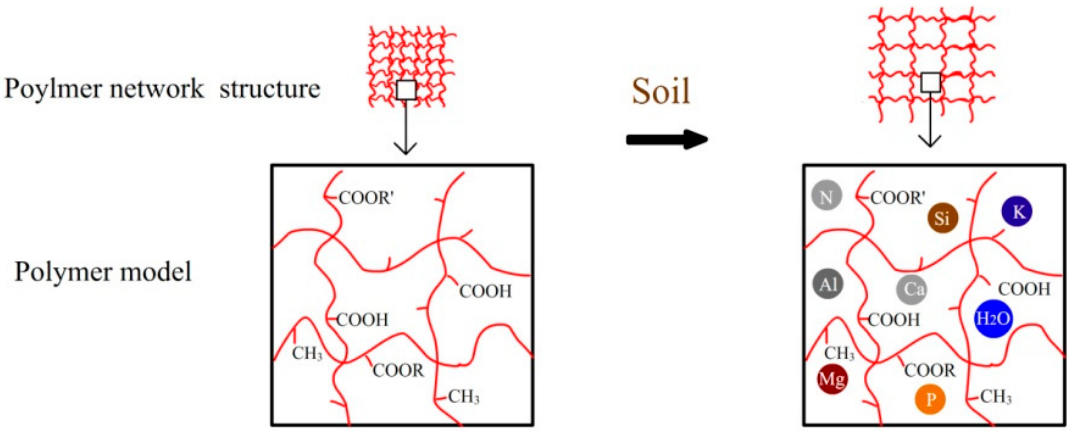
Figure 6. Schematic diagram of PA film buried in outdoor soil.